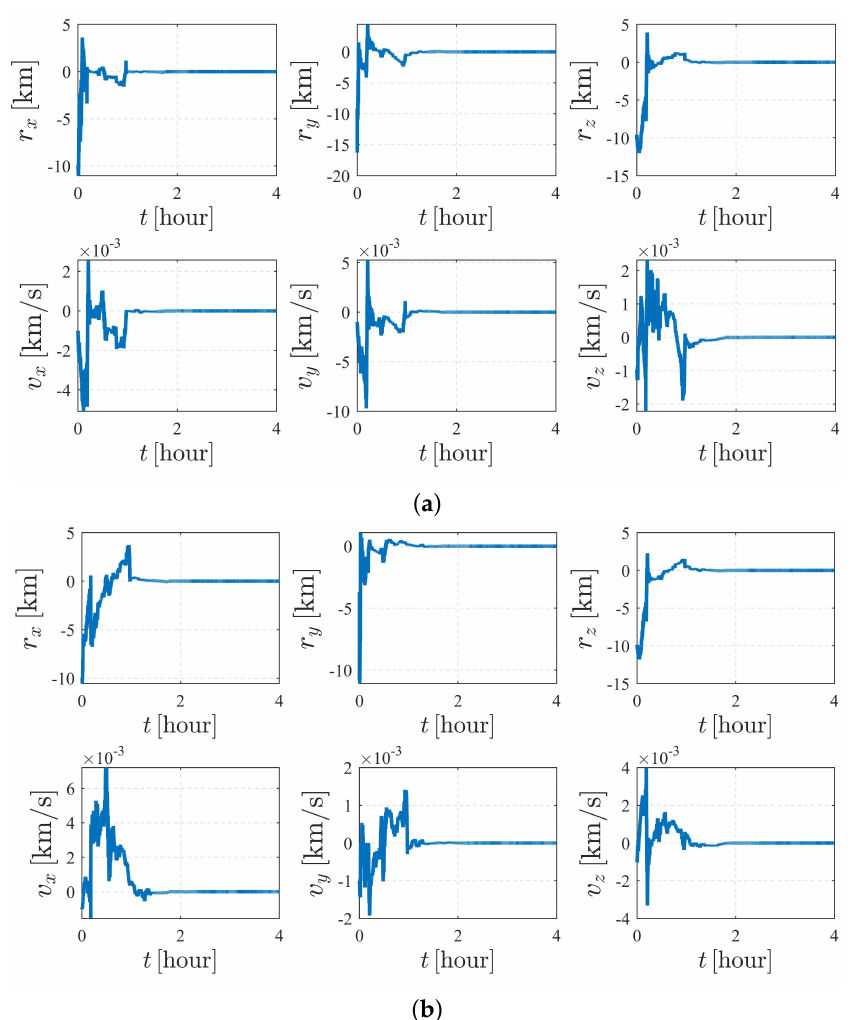
Figure 20. Orbit determination errors of case V (nonperturbation). ( a ) Orbit estimation errors of spacecraft S 1 . ( b ) Orbit estimation errors of spacecraft S 2